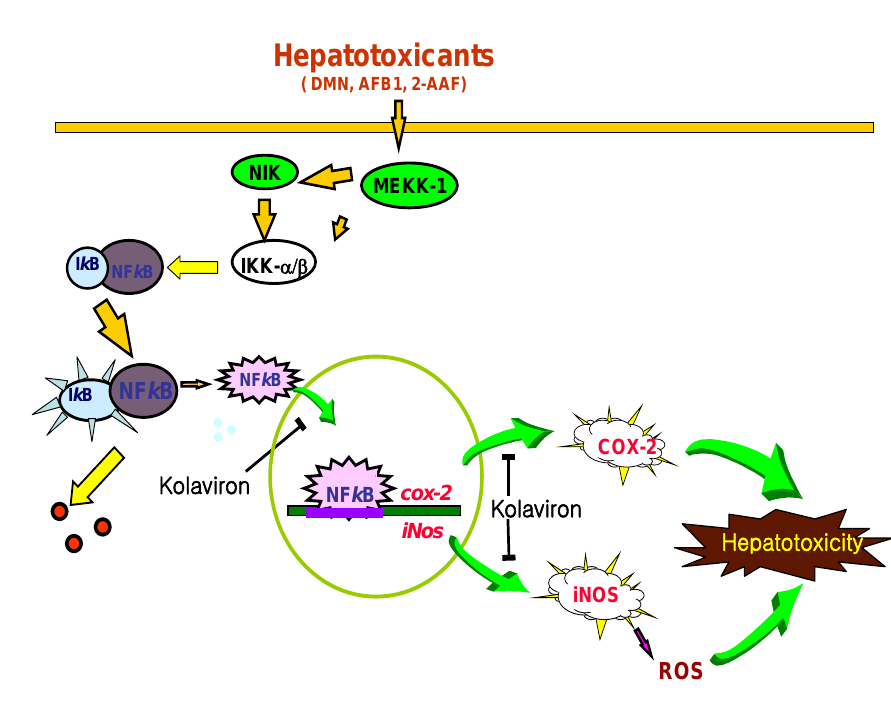
Figure 11. Proposed molecular mechanism of hepatoprotective properties of kolaviron (Adapted from Farombi